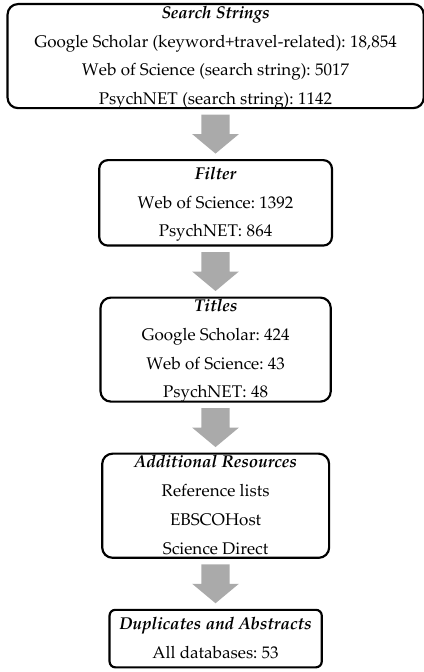
Figure 1. Literature search process.